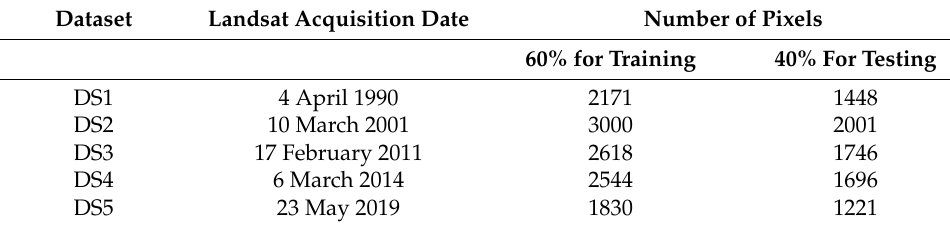
Table A3. Number of pixels for the training and the testing sets at various acquisition dates. Dataset